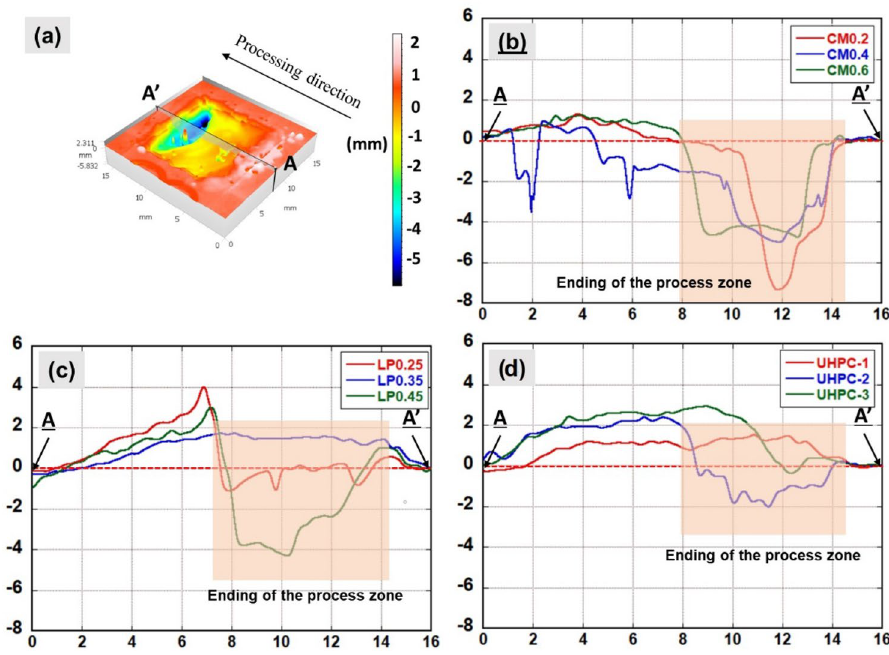
Figure 6. Cross-section profile of samples at 5 mm/s scanning speed: ( a ) 3D view of CM2; ( b ) A-A’ profile CM samples; ( c ) A-A’ profile LP samples; ( d ) A-A’ profile UHPC samples.